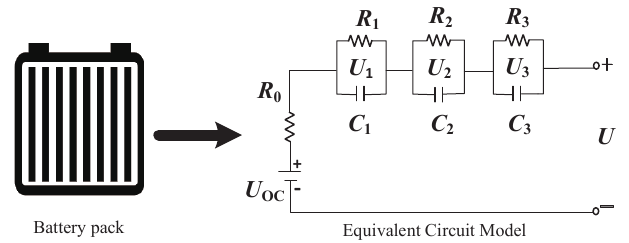
Figure 1. Third-order RC equivalent circuit